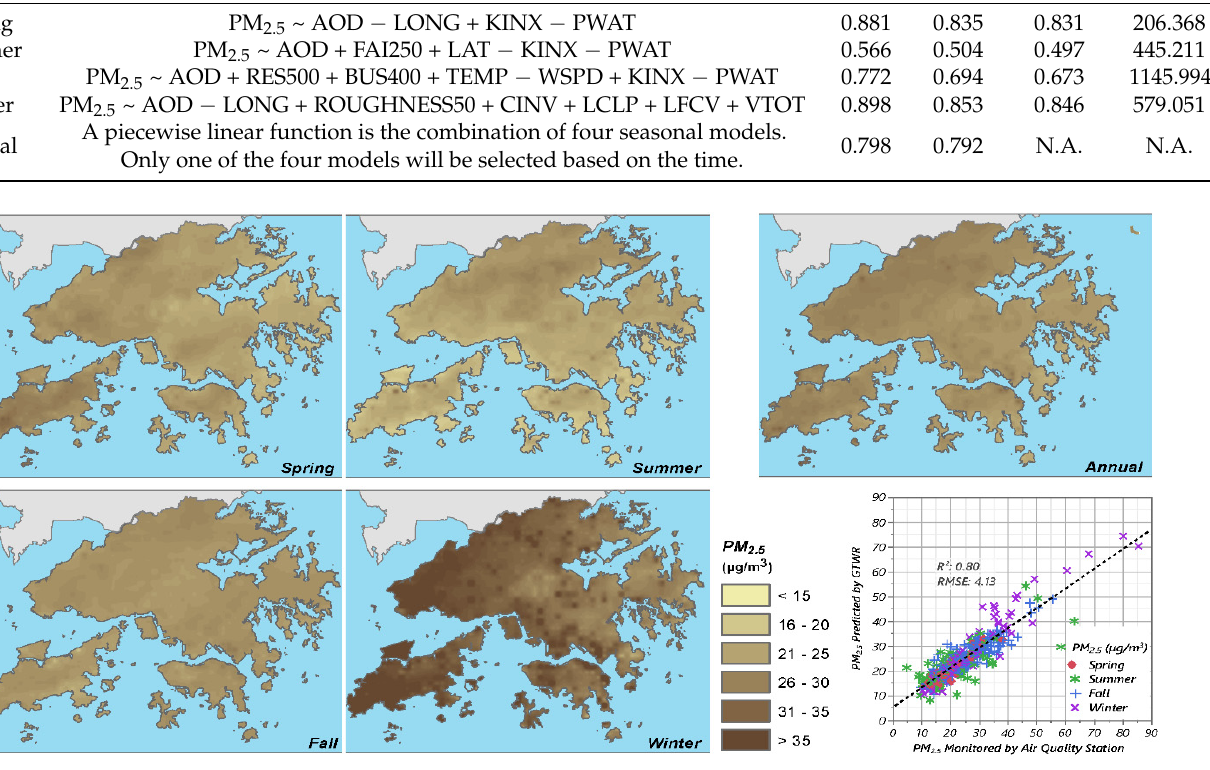
Table 2. Summary of the resultant GTWR model structures. The math operators before each predictor variable indicate its correlation with PM 2.5 . “+” indicates a positive correlation; “ − ” indicates a negative correlation. Model coefficients are shown in Table S4 of the supplementary material.